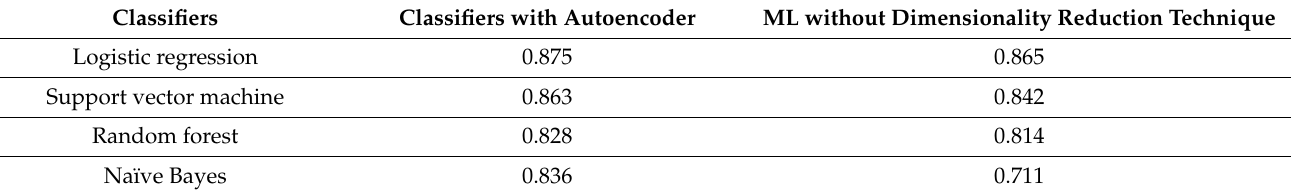
Table 4. Classifiers with dimensionality reduction and without dimensionality